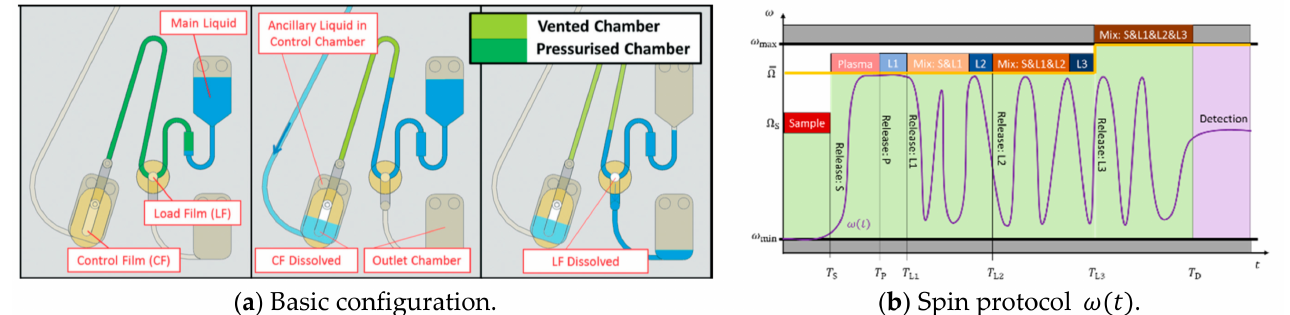
Figure 8. Principle of event-triggered flow control. ( a ) Basic valve configuration with the control film (CF), which is opened by a first liquid to vent the compression chamber of a pneumatic valve. Consequently, a second liquid is released through the load film (LF) (Adopted from [81] with permission from The Royal Society of Chemistry). ( b ) Extended corridor for the spin rate ω ( t ) in case of the event-triggered versus the rotationally actuated (Figure 6a) high-pass valves. After the sample is released at ω > Ω S , the upper boundary is defined by the, e.g., common, retention rate from their chambers is prompted by event-triggered venting, rather than raising the spin rate ω